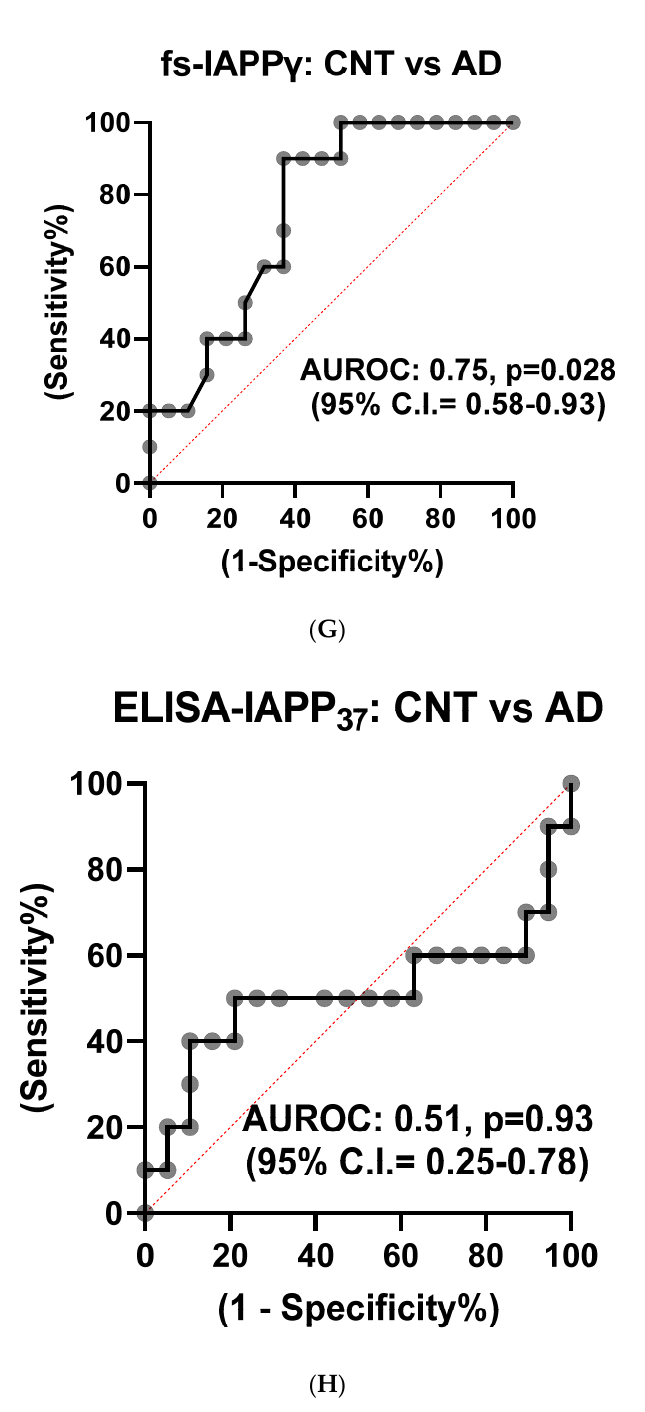
Figure 4. IAPP isoform peptide concentrations in control and AD plasma samples. Unpaired Student’s t -tests: ( A ) pro-IAPP β ; ( B ) pro-IAPP γ ; ( C ) fs-IAPP γ ; ( D ) IAPP-ELISA. The Y-axis is the ratio of peak area (light/heavy) for SRM and pg/mL for ELISA. Area under the receiver operating characteristic curve (AUROC) tests: ( E ) pro-IAPP β ; ( F ) pro-IAPP γ ; ( G ) fs-IAPP γ ; ( H ) IAPP-ELISA. The Y-axis is the true positive rate, and the X-axis is the true negative rate. ns: not